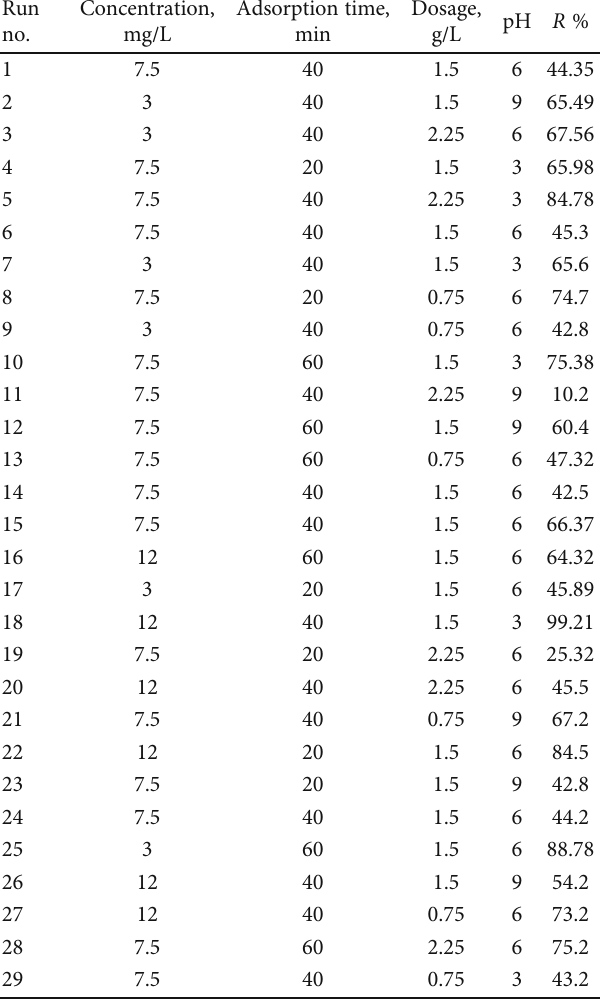
Table 1: Experimentation runs with